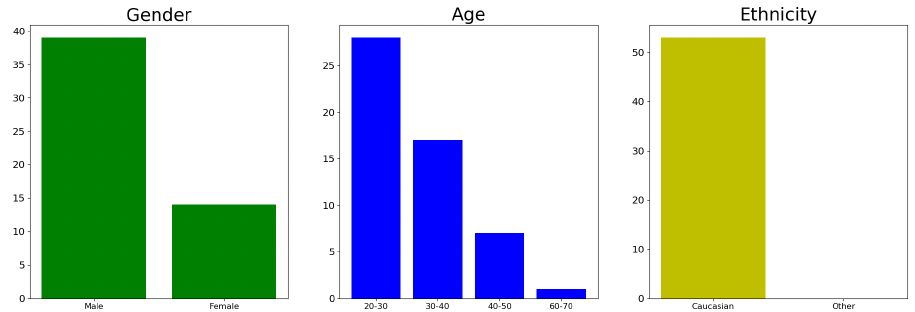
Figure 26. Demographic of subjects captured in the MICC Florence